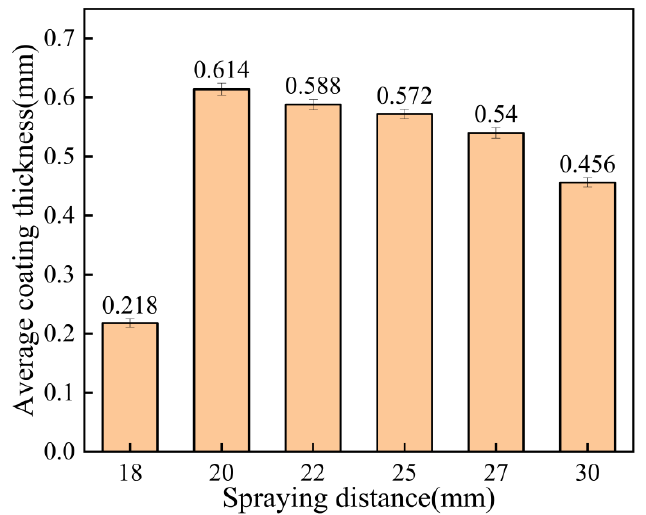
Figure 10. Average coating thickness at different spraying distances.